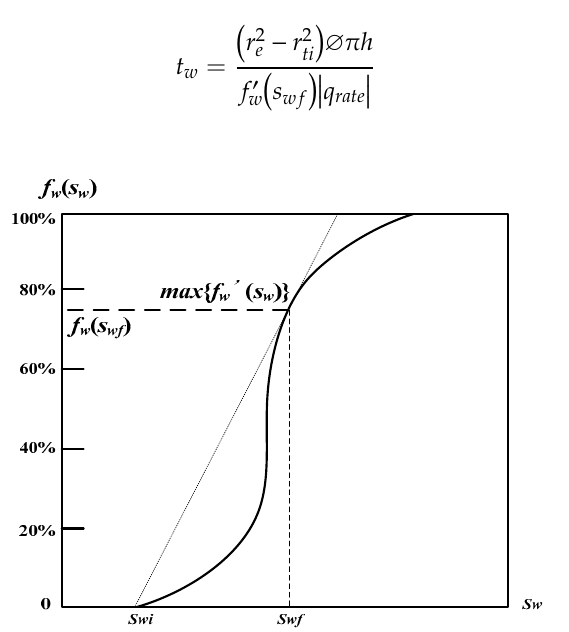
Figure 4. Schematic of water saturation of the water drive front.